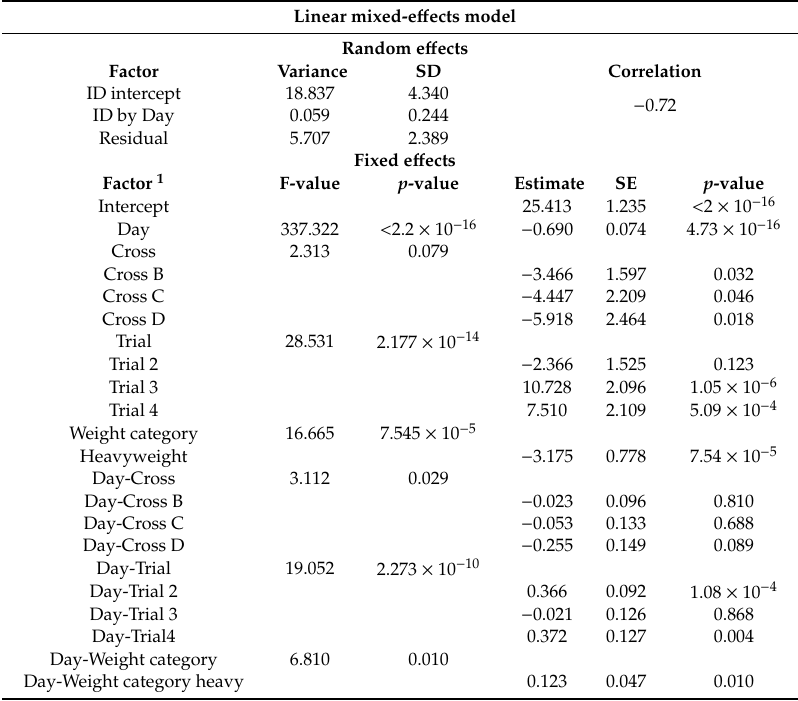
Table 3. Results of the linear mixed-e ff ects model for the predicted average activity (meters moved per hour), including type III Analysis of Variance and estimates for the di ff erent factor